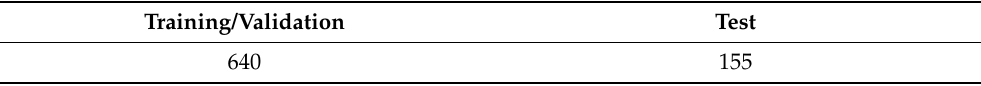
Table 2. Data volume distribution of training, validation, and test